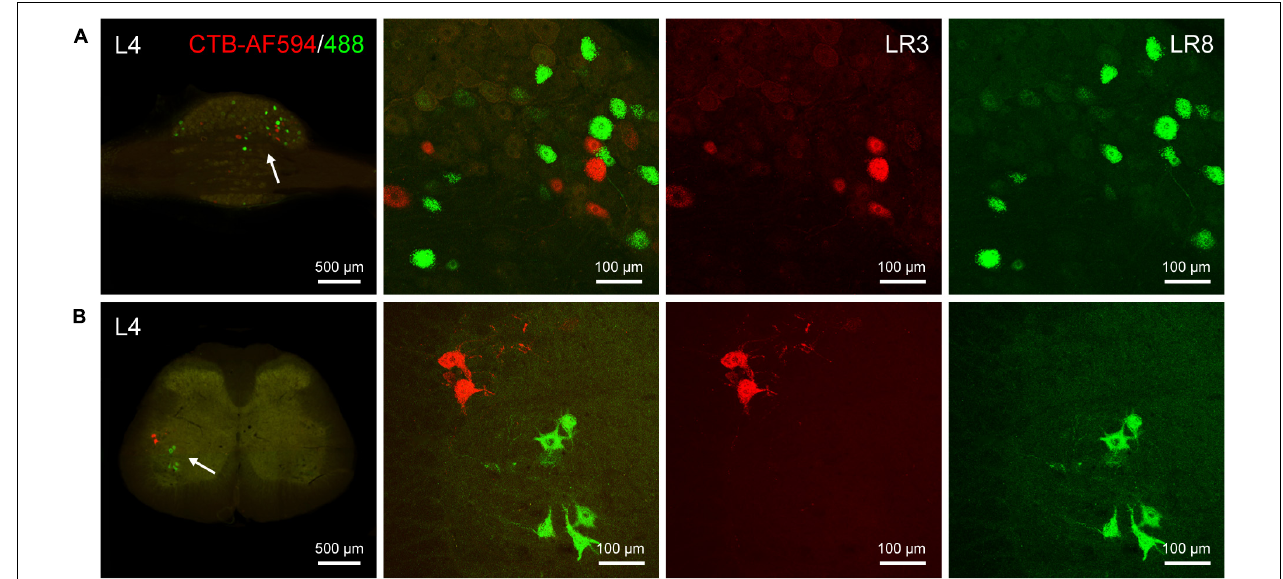
FIGURE 5 | Distribution of the labeled sensory and motor neurons with Alexa Fluor 594 and 488 conjugated cholera toxin subunit B (AF594/488-CTB) in the dorsal root ganglion and spinal cord. (A,B) Representative photos from lumbar (L) 4 dorsal root ganglion (A) and spinal cord (B) showing the labeled sensory and motor neurons associated with “Taichong” (LR3, AF594-CTB, red) and “Ququan” (LR8, AF488-CTB, green), their magnified photos (arrowheads) showing the labeled sensory (A) and motor (B) neurons in